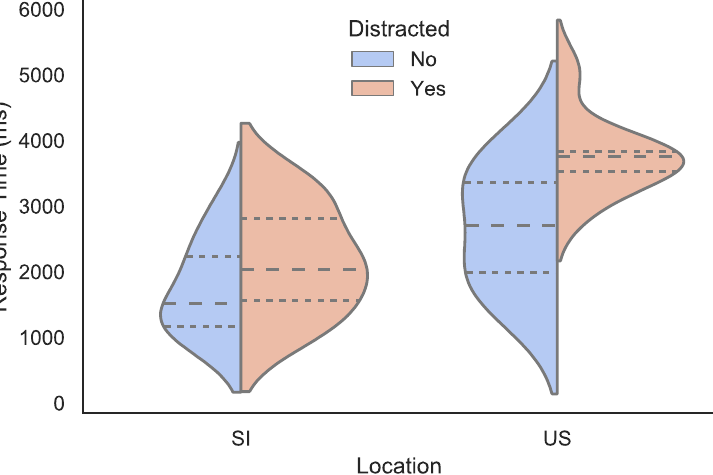
Figure 1. Take-over time per location and being distracted at TOR (with marked quartiles of the distributions). the